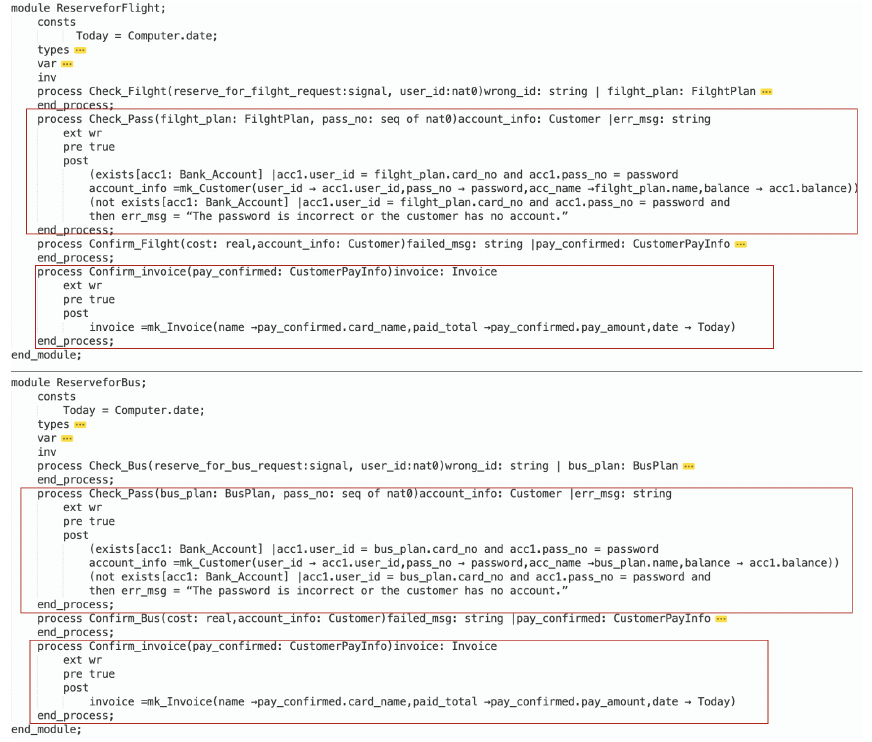
Figure 11. Formal specification of ReserveforBus and ReserveforFlight .